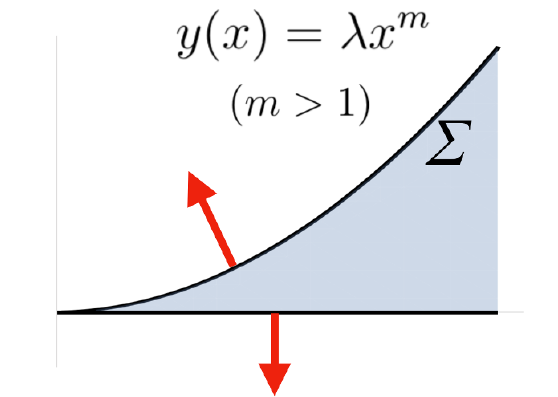
Figure 7 . We plot an entangling region on a time slice of a three-dimensional CFT bounded by the curves y = 0 and y ( x ) = (cid:21)x m ( x (cid:21) 0) with m > 1. No logarithmic term is present in the entanglement entropy. Instead, a new non-universal divergence (cid:24) 1 =(cid:14) (1 (cid:0) 1 m )